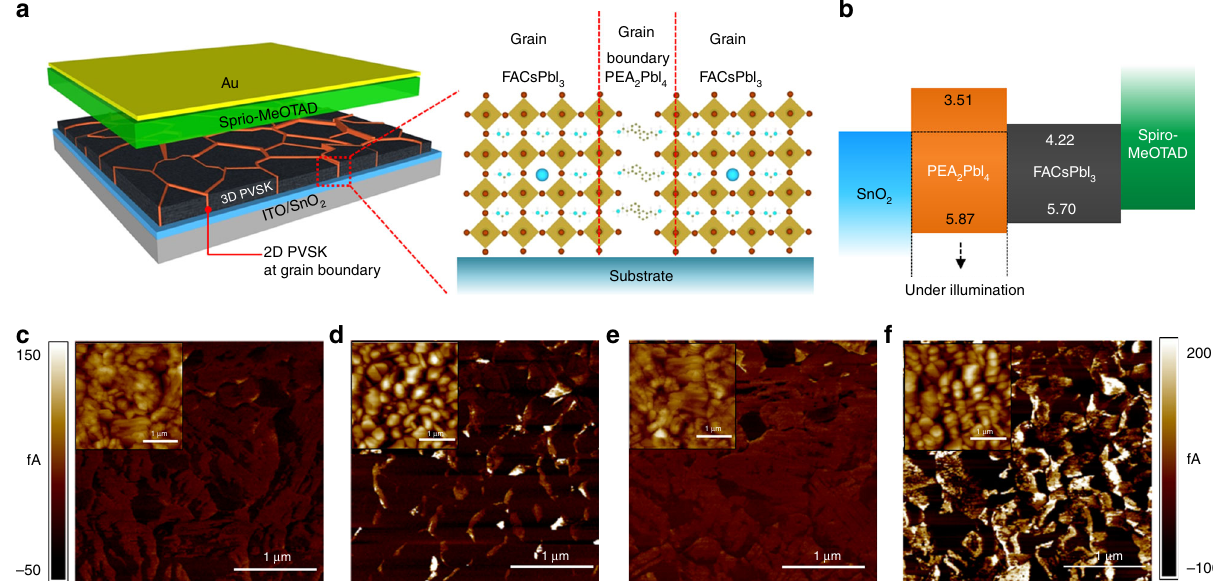
Fig. 4 Band alignment and local conductivity with 2D perovskite. a Schematics of the device incorporating polycrystalline 3D perovskite fi lm with 2D perovskite at grain boundaries and b band structure of each layer in device analyzed by ultraviolet photoelectron spectroscopy (UPS) and Tauc plots. Conductive atomic force microscopic (c-AFM) images of ( c , e ) bare FAPbI 3 and ( b , d ) with 2D perovskite fi lms on SnO 2 coated ITO glass. The measurement was carried out with bias voltage of 100 mV under ( c , d ) room light or ( d , f ) low intensity light illumination provided by the AFM setup. Inset of each image shows corresponding topology of the fi lms. Scale bar at left side is for ( c ) and ( d ) while at right side is for e and